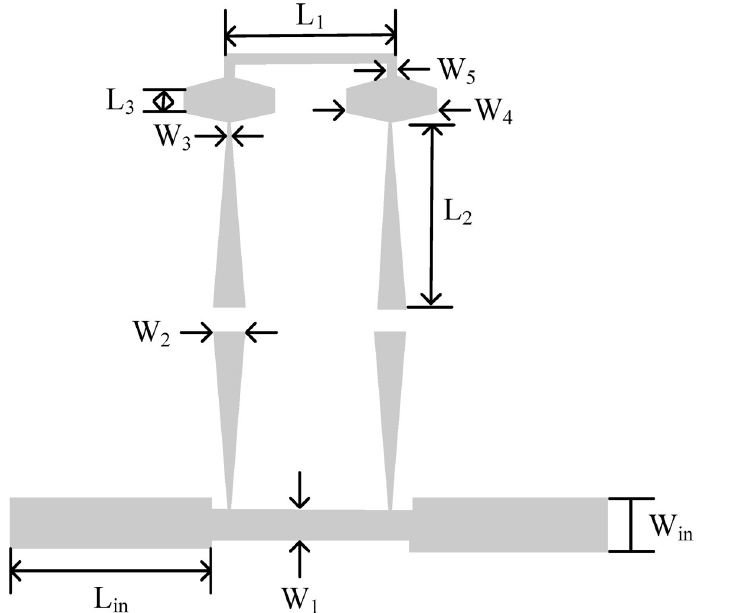
Fig 8. Transmission line model of proposed BSF.